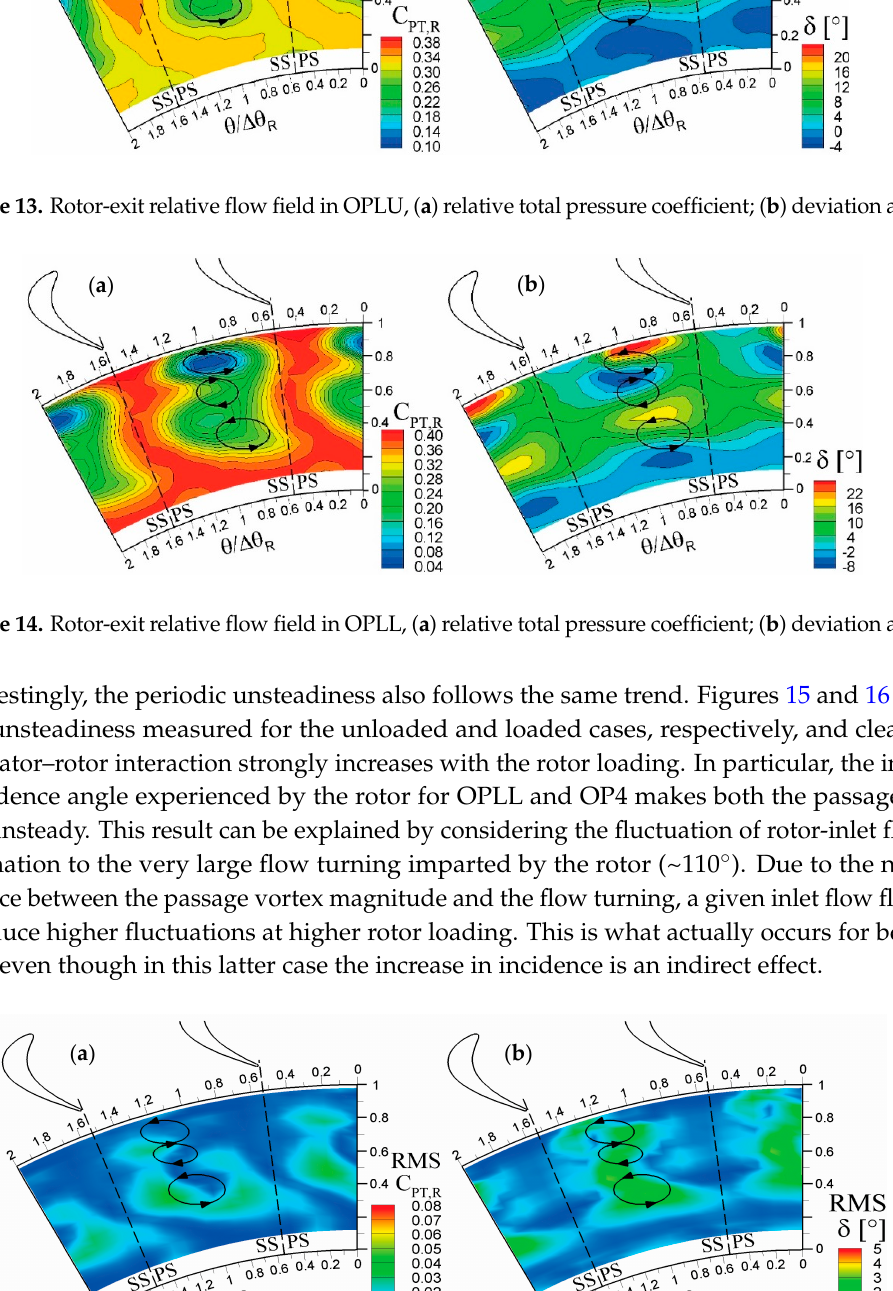
Figure 15. RMS of periodic unsteadiness for OPLU, ( a ) RMS of the relative total pressure coefficient; ( b ) RMS of the deviation angle.